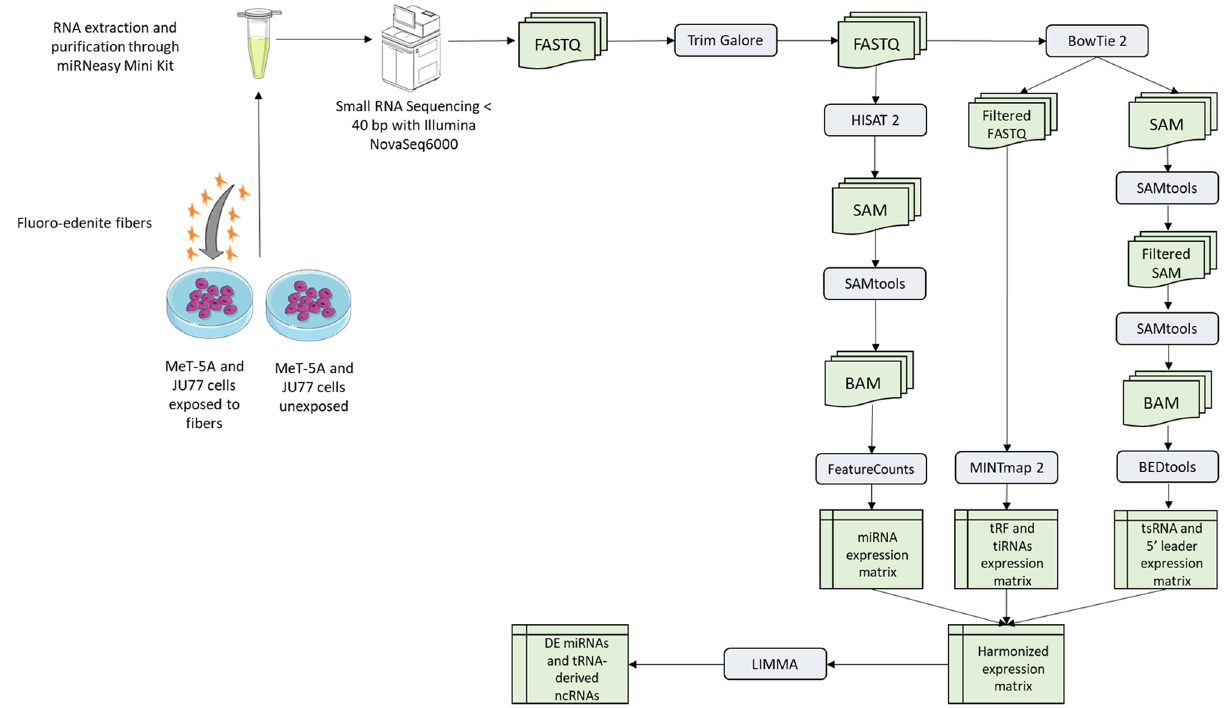
Figure 1. Experimental workflow used to extract, process, and analyze RNA from cell lines.